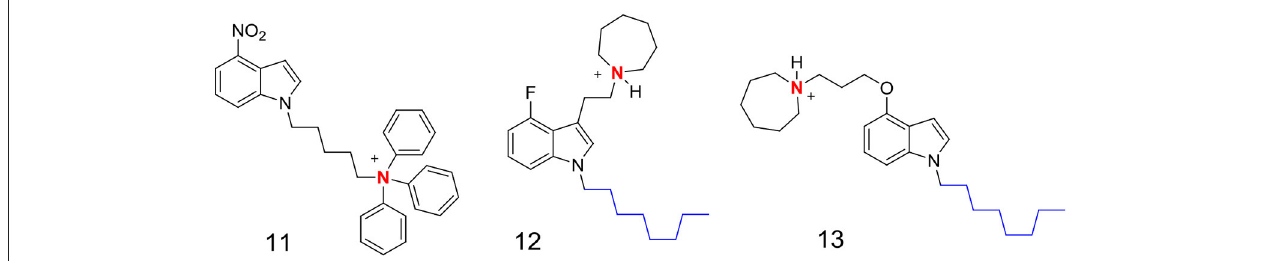
FIGURE 7 | Proposed indole-based cationic amphiphilic scaffolds. In 11 , the quarternary triphenyl ammonium moiety bears the positive charge (in red) and the lipophilic phenyl rings. In 12 and 13 , the n-octyl side chain is lipophilic (blue) and the basic nitrogen (red) is protonated (positively charged) at pH 7.4 and lower.